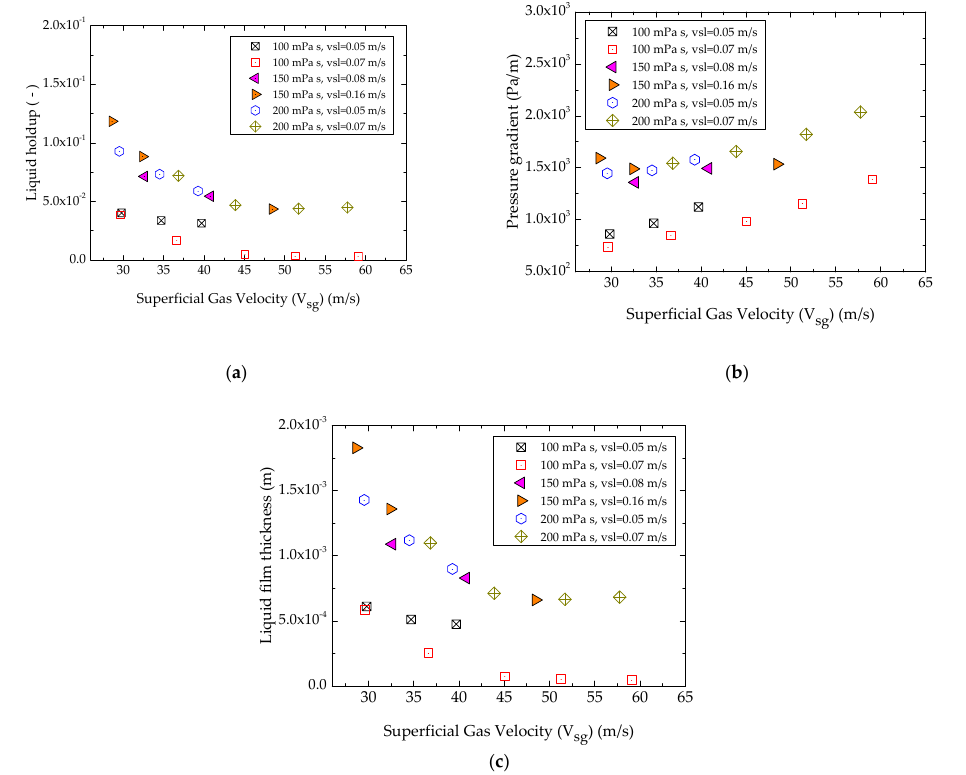
Figure 6. Experimental data showing variation of ( a ) liquid holdup, ( b ) pressure gradient and ( c ) thickness of the liquid film with superficial gas velocity for liquid viscosities of 100 mPa s, 150 mPa s and 200 mPa s, respectively, at different 𝑣 (cid:3046)(cid:3039) values. (Adopted from Ribeiro et al., [33]).